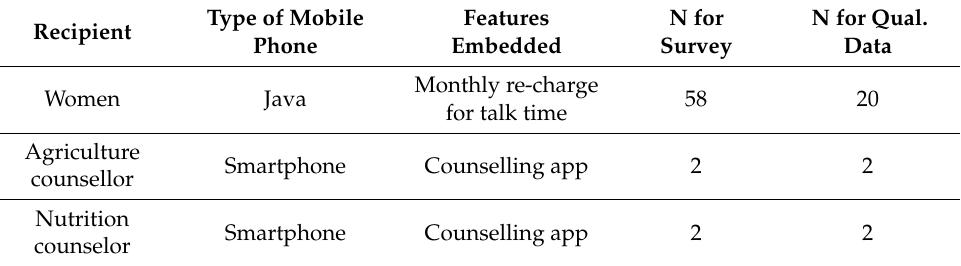
Table 1. Mobile phone features, recipients, and their participation in data